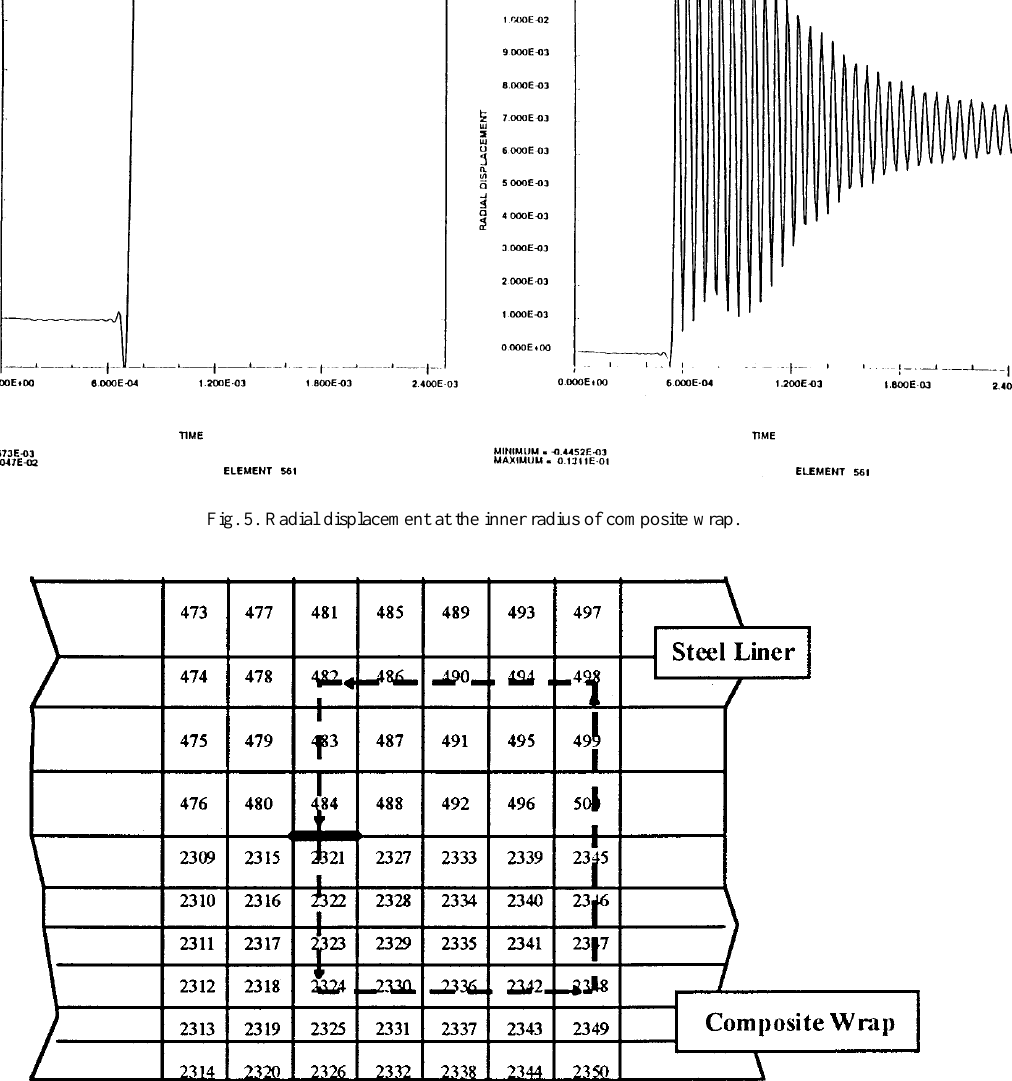
Fig. 6. FEM model and integration path near the